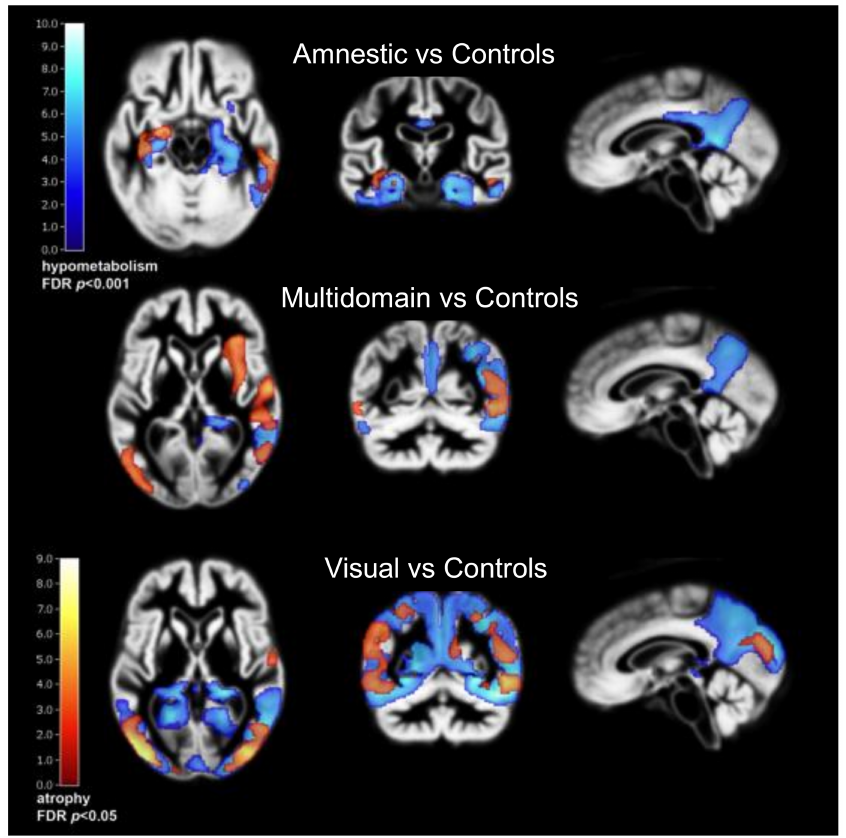
Figure 2. Metabolic impairment on FDG PET (blue) and corresponding atrophy (red), in similar location but less extensive, in three subgroups of AD which have been described in [99]. C/f C. Kobylecki, University of Manchester,